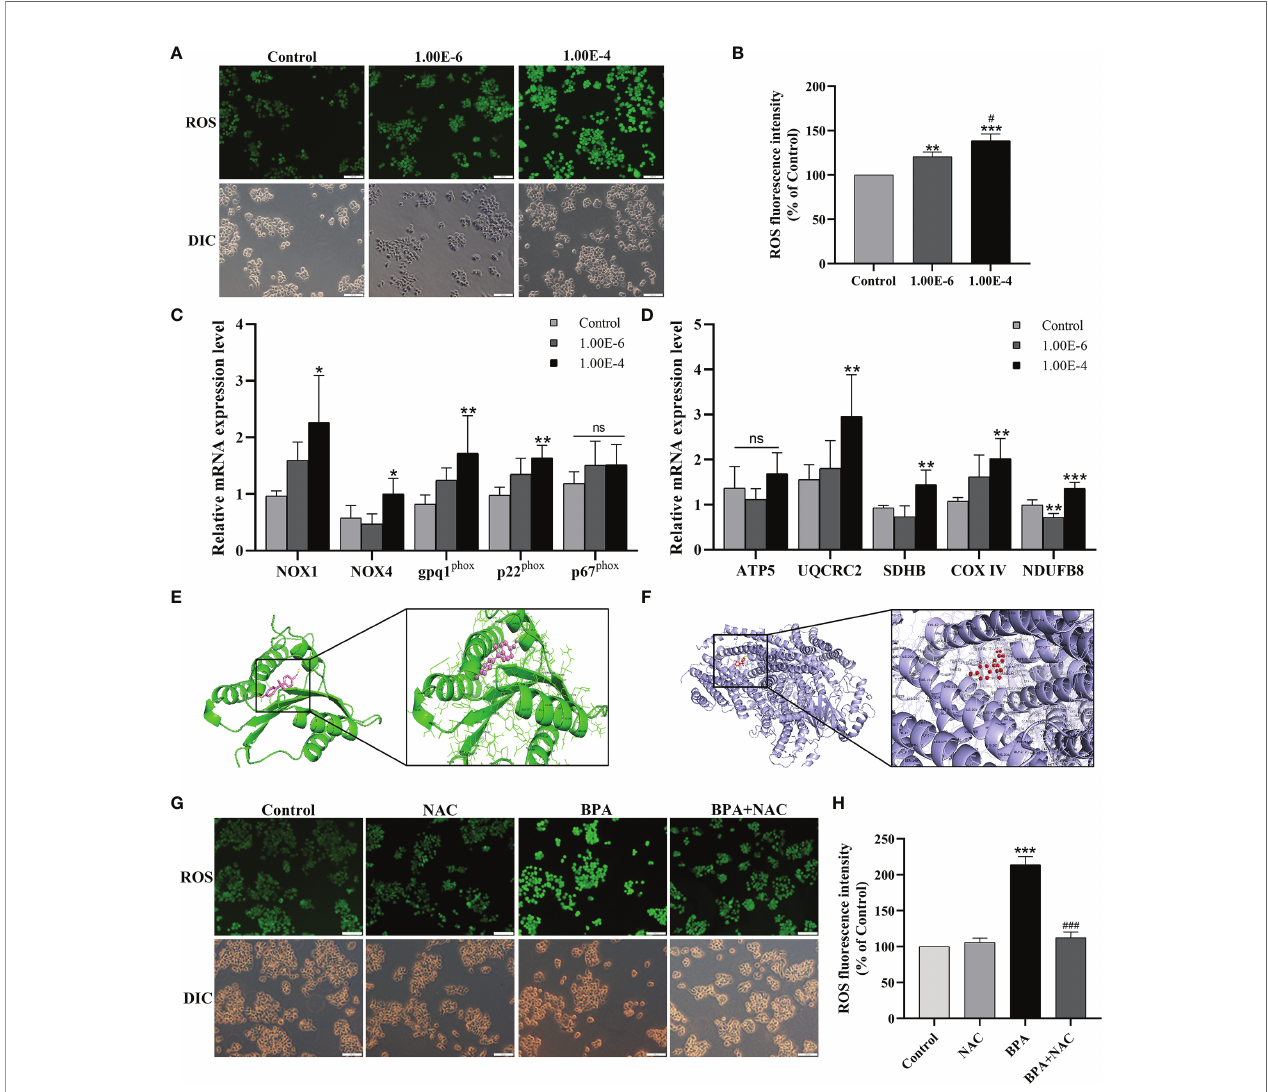
FIGURE 4 | Both NOX and mitochondrial respiratory chain involved in the ROS generation promoted by the BPA in DLD1 cells. Oxidative stress makers of ROS (A) was evaluated in DLD1 cells, and quantitative analysis of ROS (B) , n = 6. The mRNA expression levels of NOX subunits (C) and mitochondrial respiratory chain complexs (D) , n = 6. (E) 3D docking model of BPA with NOX. BPA was shown as pink sticks and NOX as green ribbons. The hydrogen bonds are indicated by yellow dashed lines. (F) BPA with ETC protein in the region of binding site. ETC protein was represented in blue, and the structures of BPA were colored by red. The yellow dashed lines indicated hydrogen bond. (G) DLD1 cells were treated with 1 × 10 -4 mM BPA for 24 h in the presence or absence of the ROS inhibitor NAC. The level of ROS (G) and quantitative analysis of ROS (H) , n = 6. Values are expressed as means ± SD, compared with the control group, * p < 0.05, ** p < 0.01, *** p < 0.001. Compared with the 1.00E-6 BPA group, # p < 0.05, ### p < 0.001. ns, no signi fi